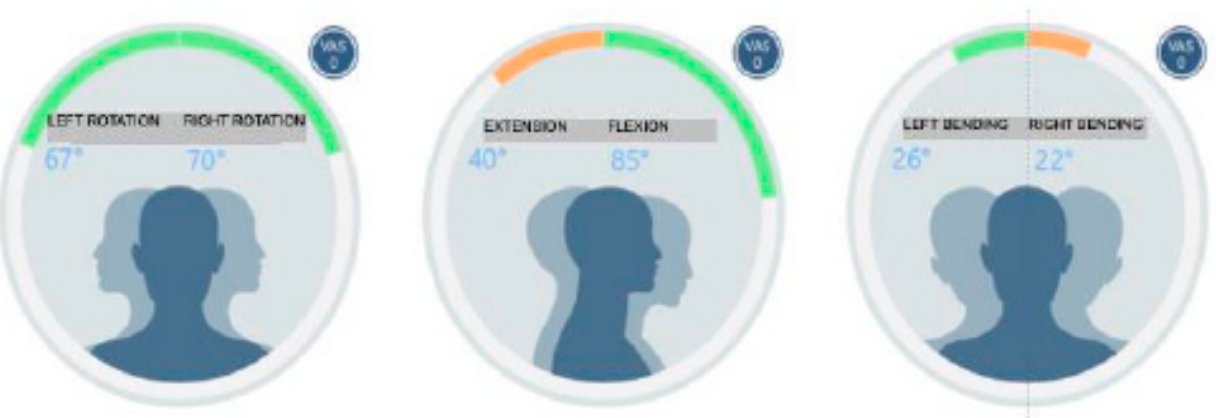
Figure 29. Evaluation of cervical